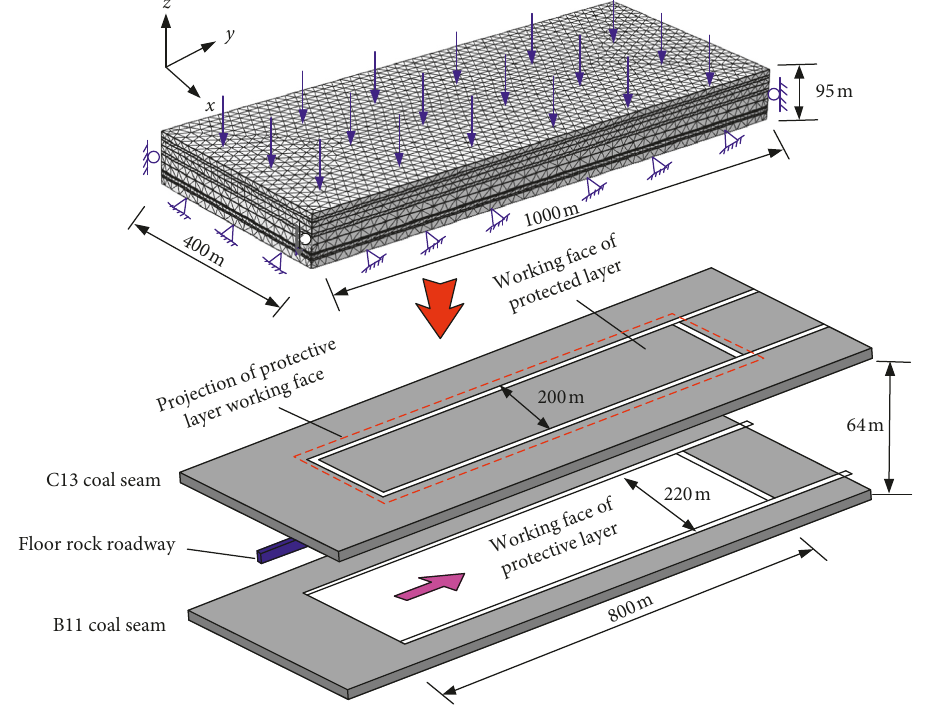
Figure 3: Geometric model for numerical Table 1: Mechanical properties of overlying strata.